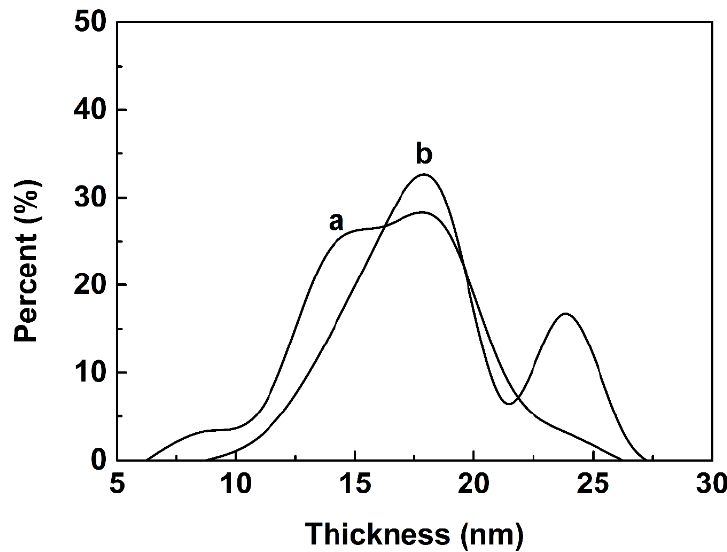
Figure 8. Thickness distribution of the Al(OH) 3 nanosheets: (a) A23H6 and (b) A27H6.